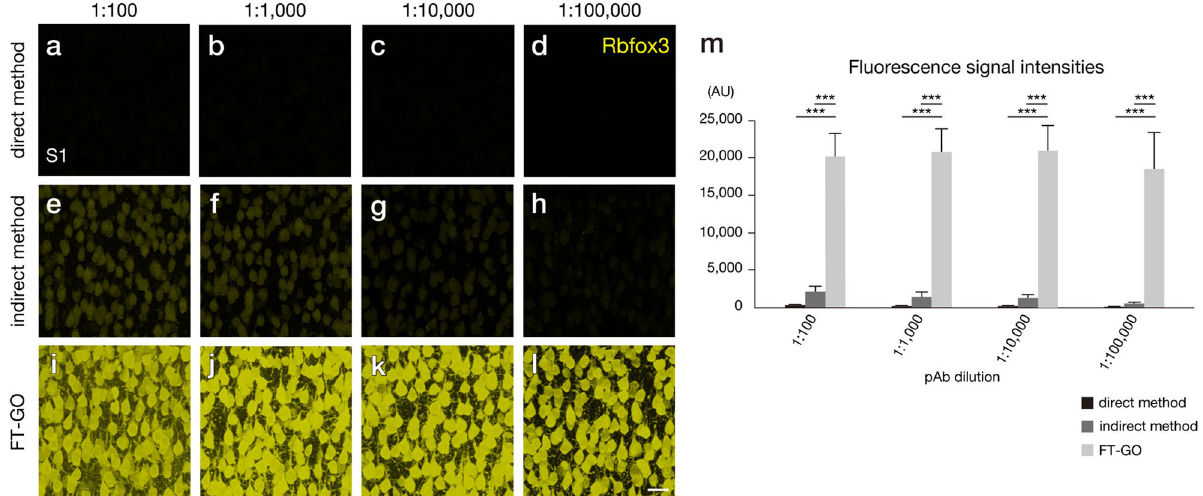
Figure 2. Signal amplification in IF with FT-GO. (a–l) IF for Rbfox3 using a direct ( a–d ), indirect (e–h ) and FT-GO method ( i–l ) in layer 2/3 neurons of the mouse S1 (n = 3 animals for each condition). Brain sections were reacted with an anti-Rbfox3 Ab at dilutions of 1:100 ( a,e,i ), 1:1000 ( b,f,j ), 1;10,000 ( c,g,k ) and 1:100,000 ( d,h,l ). CF488A tyramide is used for color development in the FT-GO method. Images are acquired with the same parameters for comparisons. ( m) Histograms representing fluorescence signal intensities (AU) of Rbfox3- positive cells in the layer 2/3 of S1 (n = 630 cells, primary [pAb] 1:100, direct method; n = 644 cells, pAb 1:100, indirect method; n = 686 cells, pAb 1:100, FT-GO; n = 622 cells, pAb 1:1000, direct method; n = 698 cells, pAb 1:1000, indirect method; n = 758 cells, pAb 1:1000, FT-GO; n = 620 cells, pAb 1:10,000, direct method; n = 639 cells, pAb 1:10,000, indirect method; n = 728 cells, pAb 1:10,000, FT-GO; n = 650 cells, pAb 1:100,000, direct method; n = 619 cells, pAb 1:100,000, indirect method; n = 686 cells, pAb 1:100,000, FT-GO; n = 3 animals for each condition, pAb 1:100; H = 1737, df = 2, P < 0.0001, Kruskal–Wallis test, pAb 1:1000, H = 1832, df = 2, P < 0.0001, Kruskal–Wallis test, pAb 1:10,000; H = 1744, df = 2, P < 0.0001, Kruskal–Wallis test, pAb